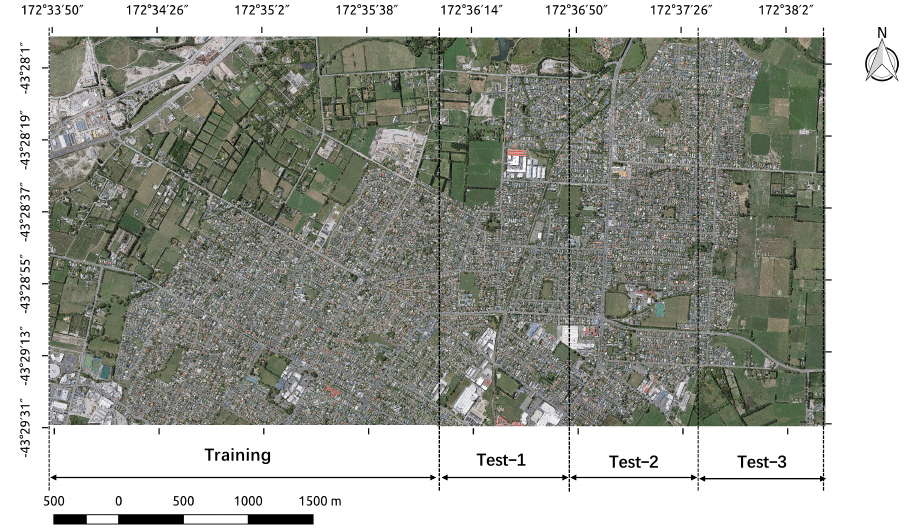
Figure 1. Aerial imagery of the study area. The area covers 18 km 2 of residential area, factories or farms in New Zealand, and is located from –43 ◦ 28 (cid:48) (N) to –43 ◦ 30’(S) and 172 ◦ 34’(W) to 172 ◦ 38 (cid:48) (E).